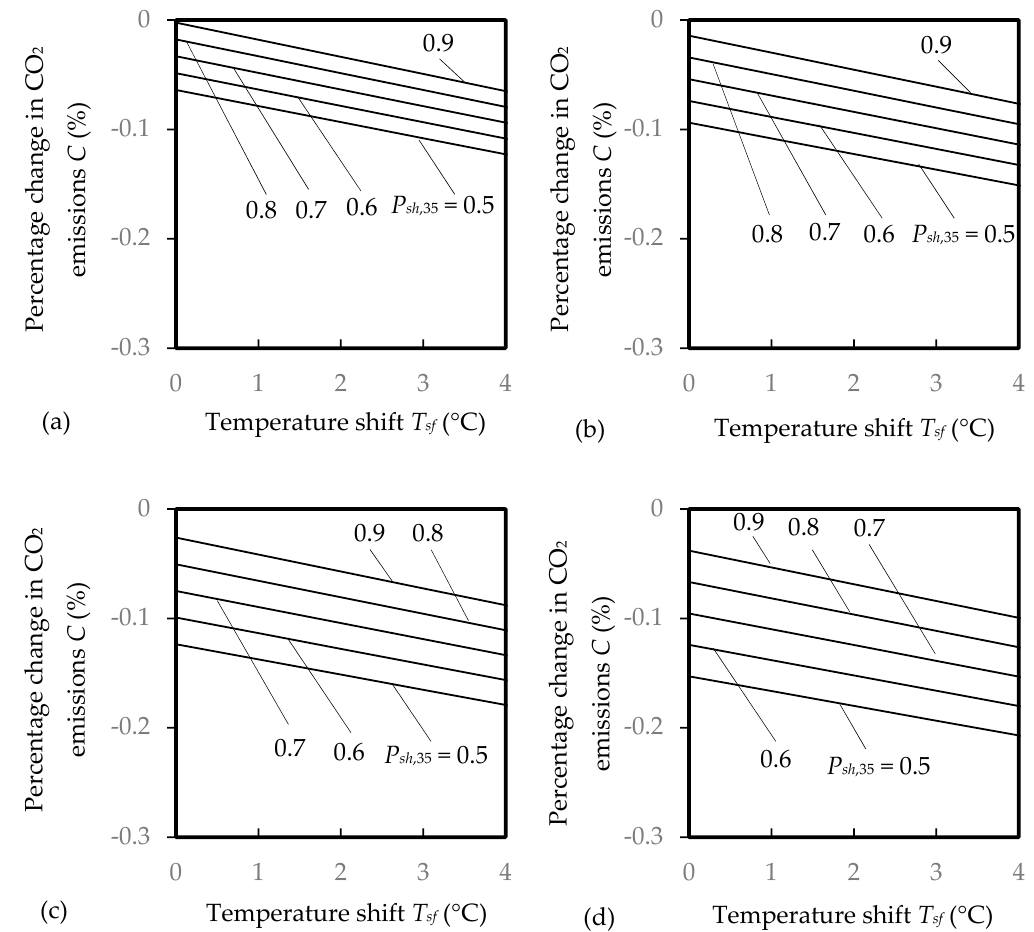
Figure 6. User influence on the percentage change in CO 2 emissions: ( a ) ∆ T a = 0 °C; ( b ) ∆ T a = 1 °C; ( c ) ∆ T a = 2 °C; ( d ) ∆ T a = 3 °C.